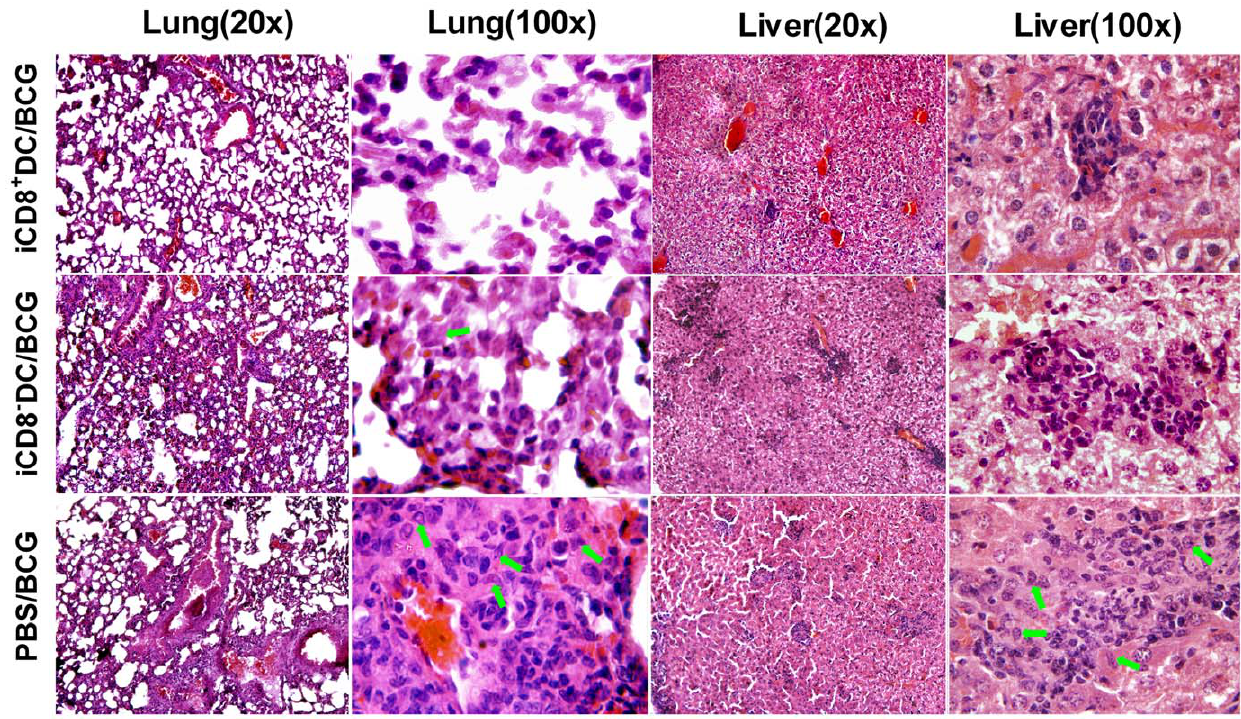
Figure 5. Significantly milder pathological changes in recipients of iCD8 + DC following intravenous challenge infection. Mice were treated/challenged as described in the legend to Figure 4 and analyzed for histopathological changes in lung and liver at day 21 post challenge infection by H&E staining. Low magnification(x20) and high magnification (x100) were shown respectively. Green arrows indicate typical epithelioid